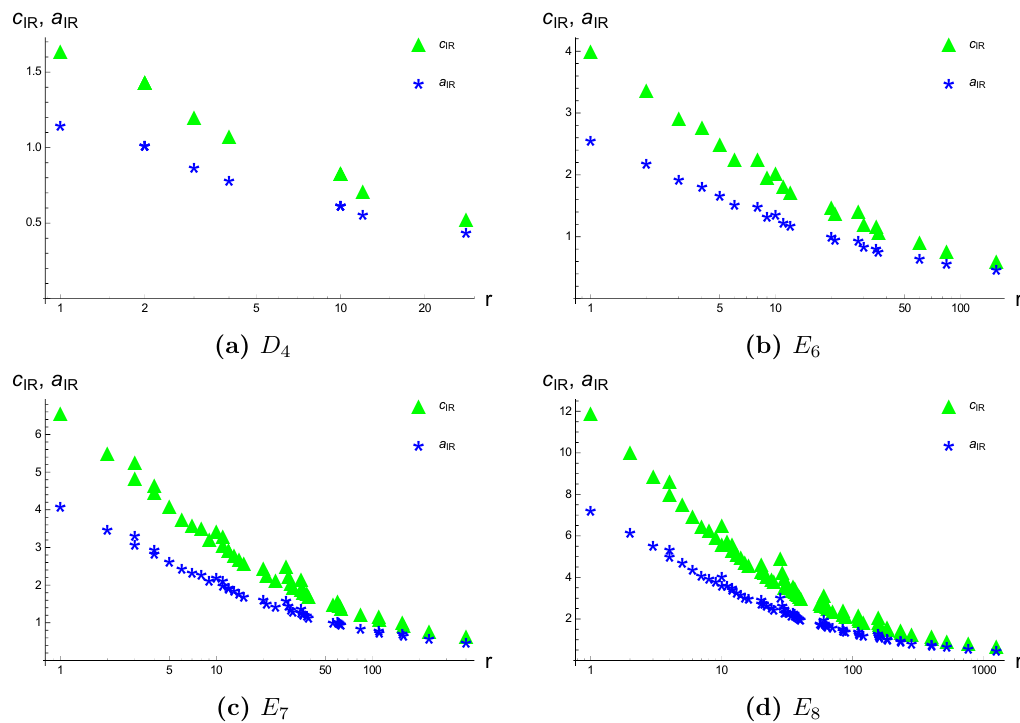
Figure 6. Plots of a IR (blue stars) and c IR (green triangles) vs embedding index r for the di(cid:11)erent (cid:13)ipper (cid:12)eld deformations of probe D3-brane